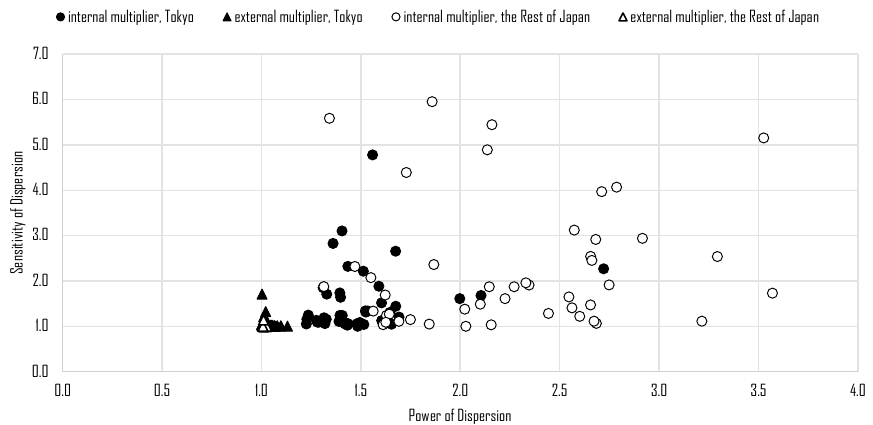
Fig. 5 Power and sensitivity of dispersion of partitioned multipliers in two-region. Source: Author’s construction based on Tokyo Metropolitan Government